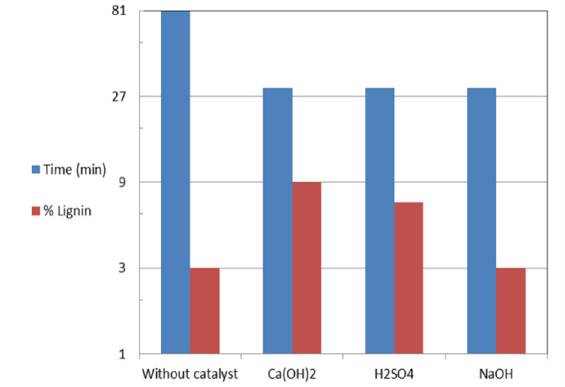
Fig. 7. Effect of different catalysts on lignin percentage content. Conditions are 185 o C, and ratio ethanol: water = 50:50